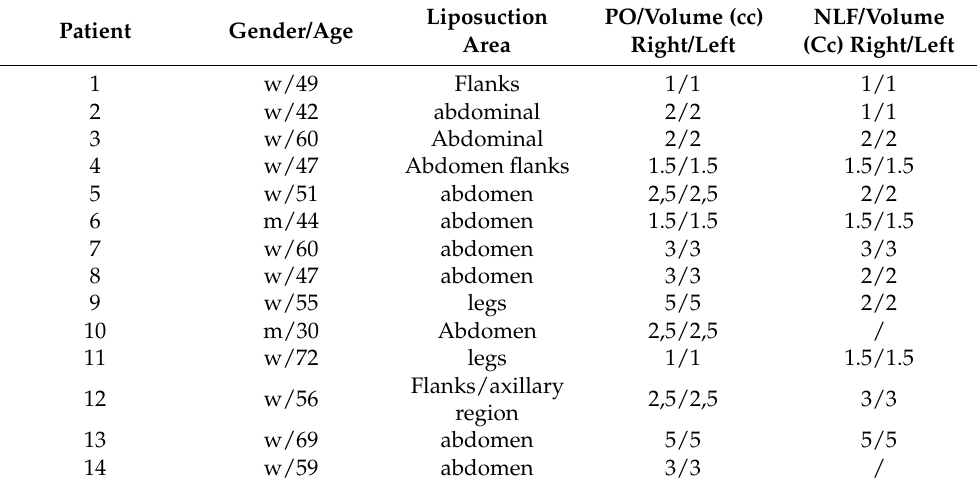
Table 1. Follow up 6 weeks: Survey of patients undergoing lipofilling for rejuvenation for nasolabial and periorbital folds ( n =